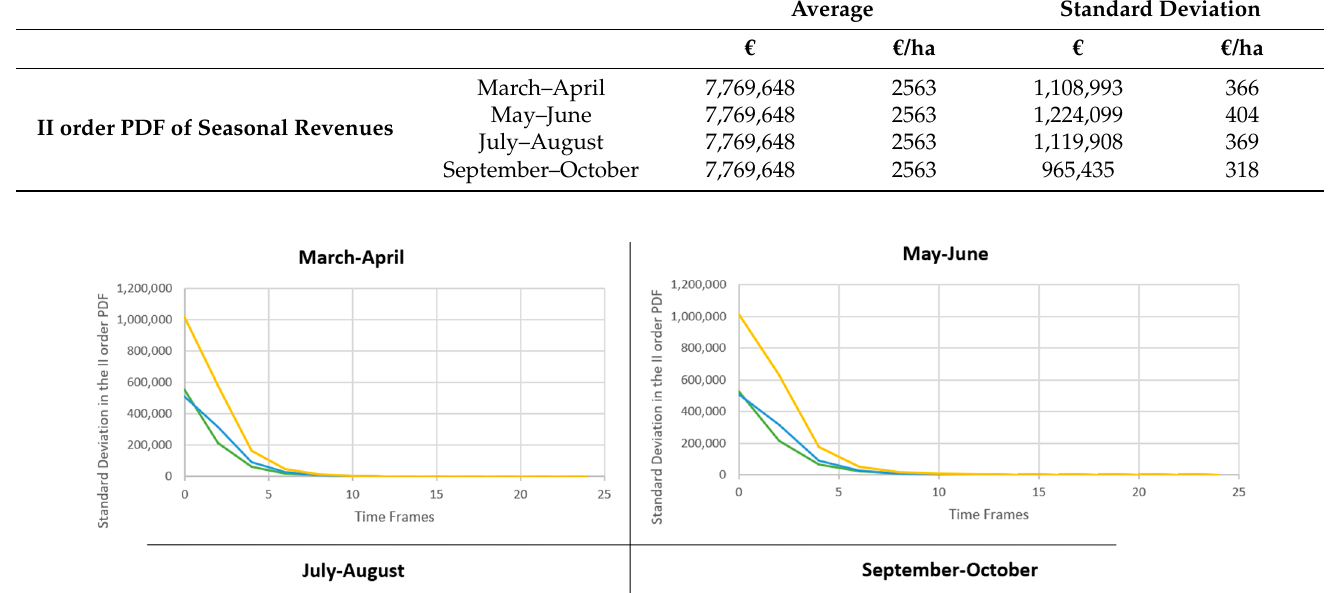
Figure 4. II Order PDF of revenues in the district for the period March–April. Table 2. Parameters of the II Order PDF representing ambiguity in the district. Average Standard Deviation € € /ha € € /ha